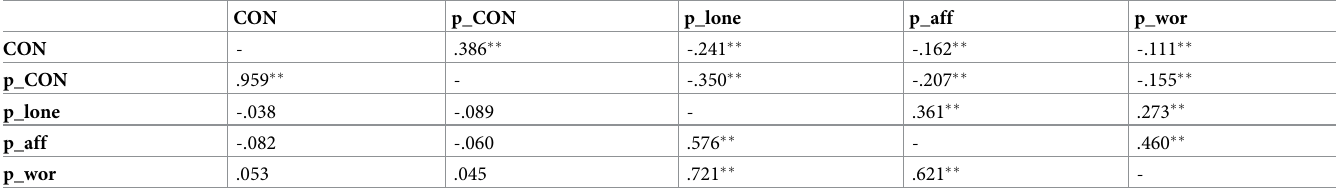
Table 4. Within-person (above diagonal) and between-person (below diagonal) intercorrelations among study variables concerning situational psychological states and current/subsequent social contacts.